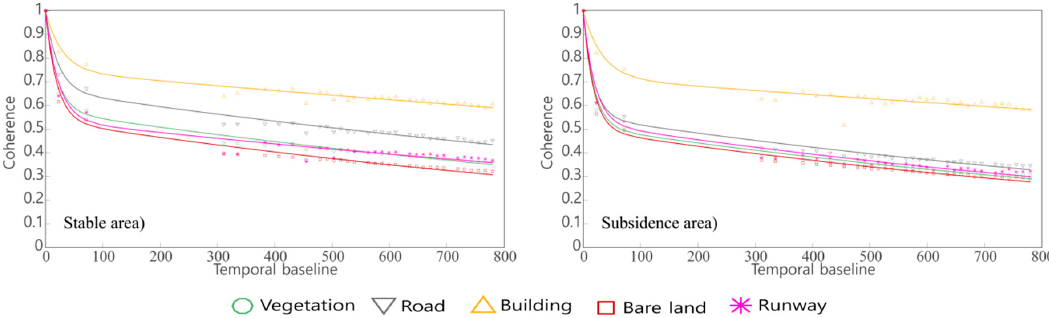
Figure 8. The left is the relationship between temporal baseline and coherence of different land cover types in the stable area. The right is in the subsidence area.